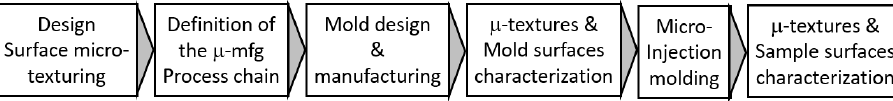
Figure 2. Research